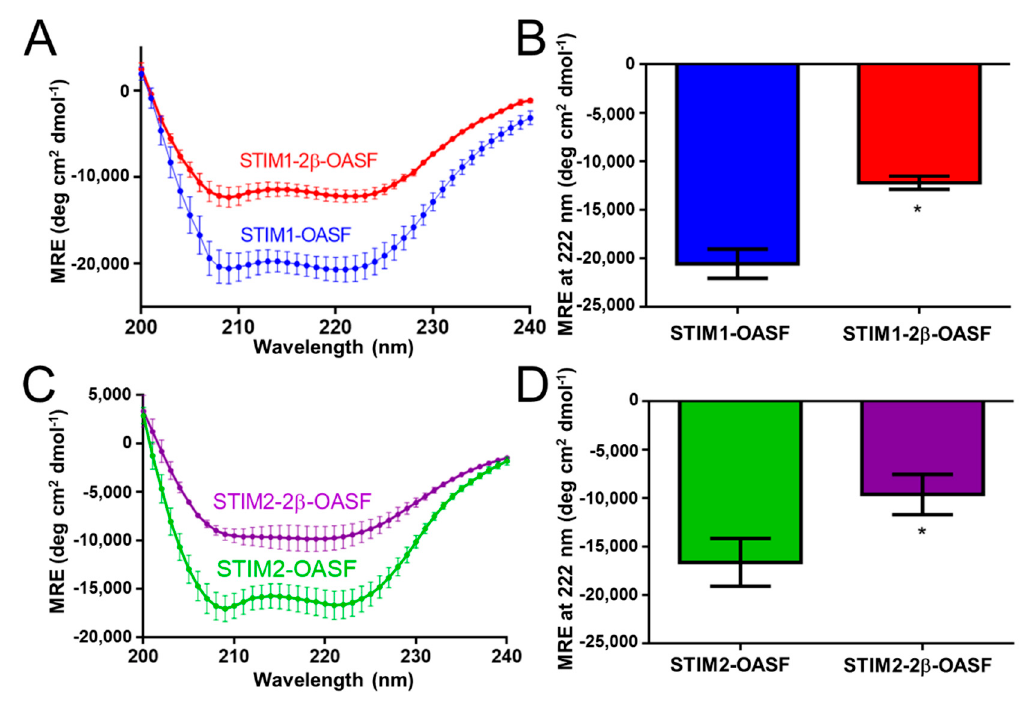
Figure 2. Secondary structure of STIM OASF proteins. ( A ) Far-UV CD spectra of STIM1-OASF and STIM1-2 β -OASF. ( B ) Comparison of STIM1-OASF and STIM1-2 β -OASF mean residue ellipticity (MRE) at 222 nm. ( C ) Far-UV CD spectra of STIM2-OASF and STIM2-2 β -OASF. ( D ) Comparison of STIM2-OASF and STIM2-2 β -OASF MRE at 222 nm. Spectra were acquired using 0.2 mg·mL − 1 protein at 20 °C. Data are means ± SEM of n = 3 separate protein purifications. In ( B , D ), * p < 0.05 using Student’s t -test.